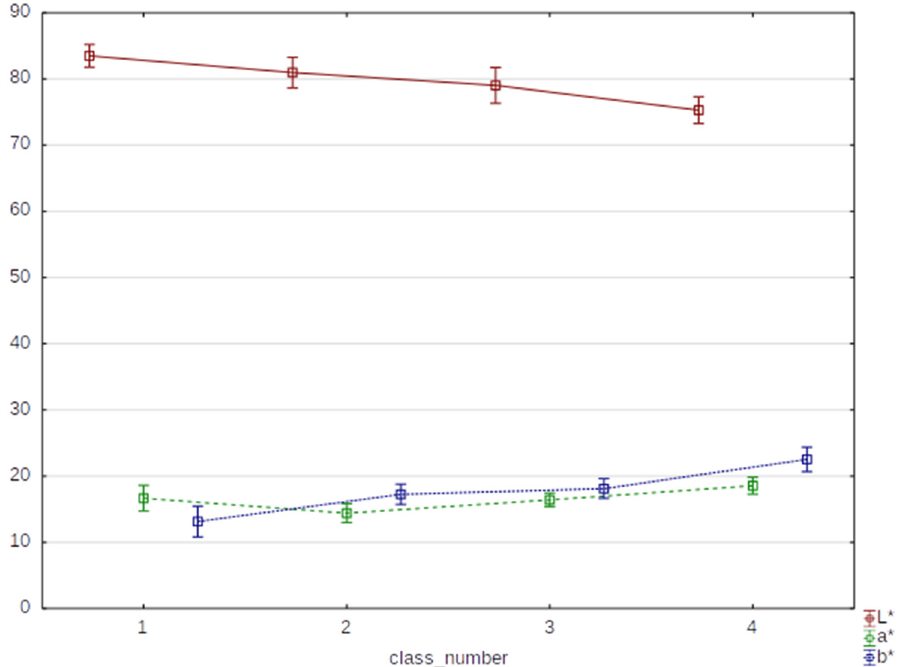
Figure 3. Mean values and 0.95 confidence intervals for the color parameters expressed in the CIE L* a* b* system for samples belonging to classes 1–4, which corresponded to drying temperatures of 60, 70, 80, and 90 °C.